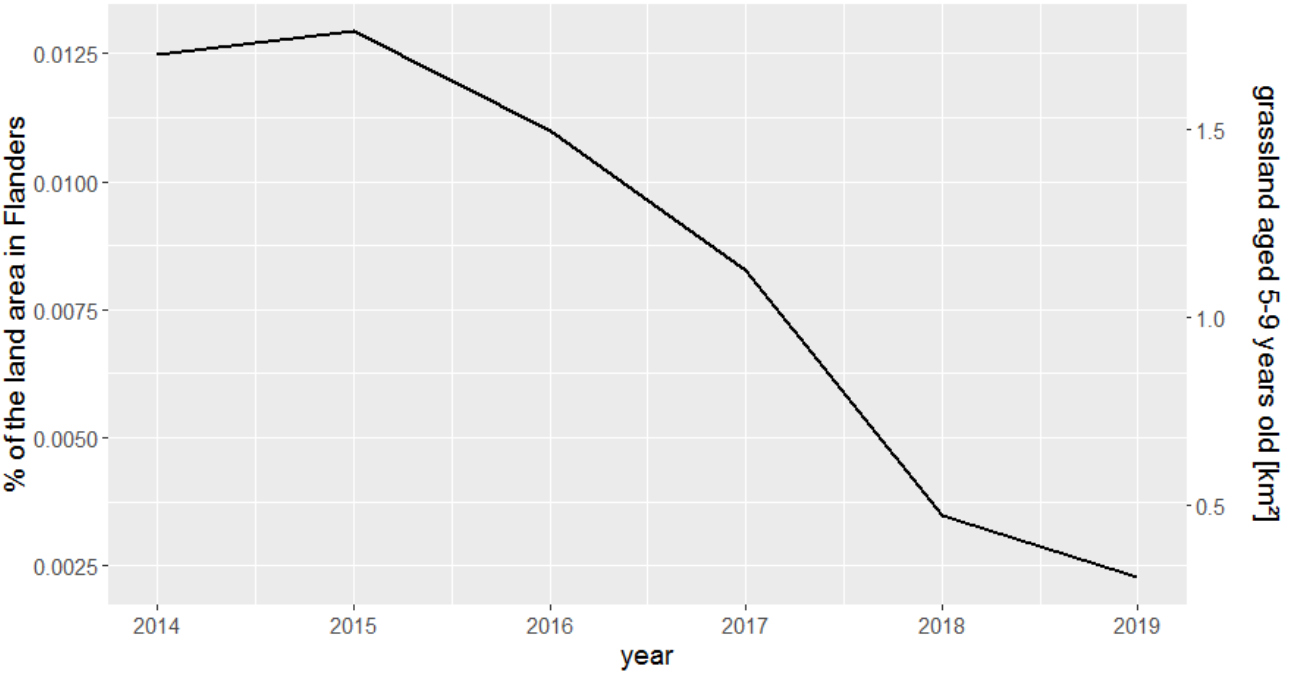
Figure 5. Area of long-term grassland aged 5–9 years old from 2014 to 2019 in Flanders, expressed as percentage of Flanders (left axis) and km² (right axis). The area of long-term grassland aged 5–9 years old was derived from the historical land cover classification maps from 2005 to 2019.